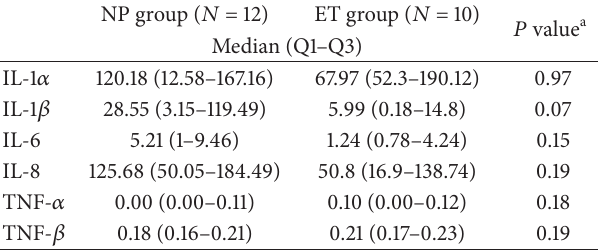
Table 2: Baseline proinflammatory cytokine profiles of study subjects by treatment outcome